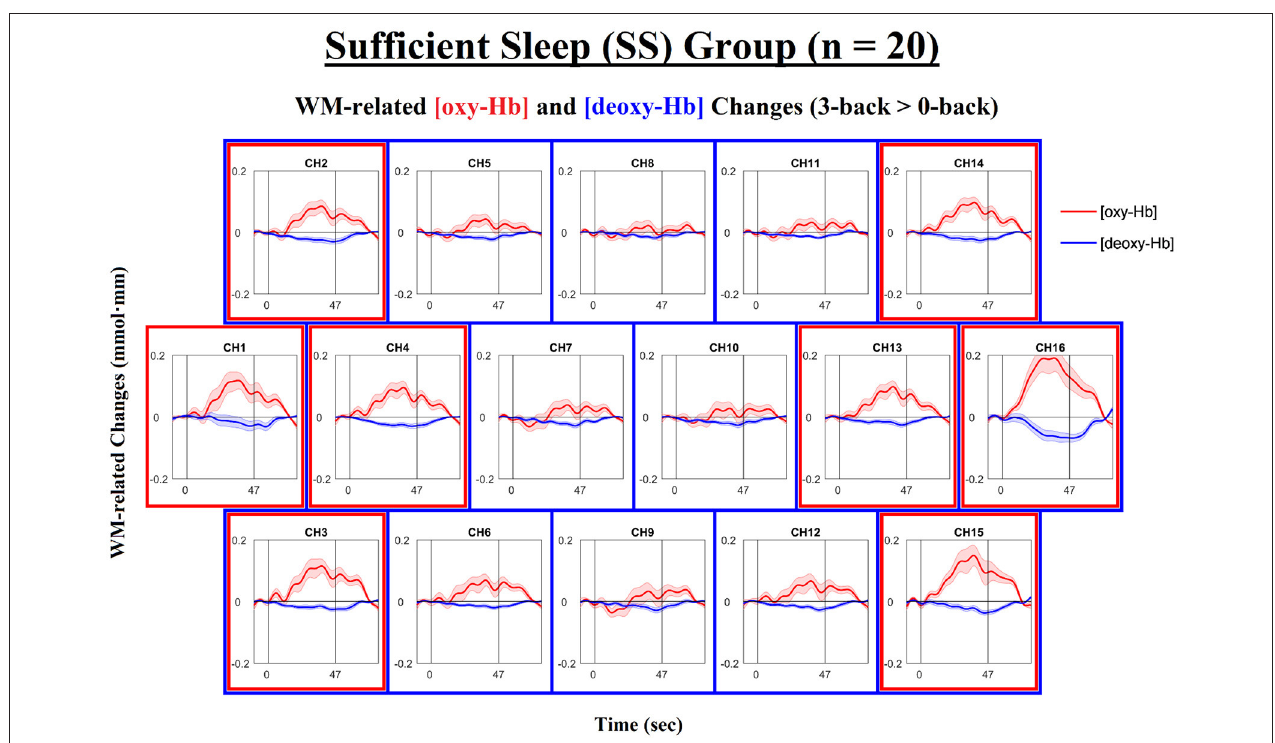
FIGURE 3 | Time courses of the working-memory-related (WM-related, i.e., 3-back minus 0-back) [oxy-Hb] and [deoxy-Hb] changes in the Sufficient Sleep group (SS; n = 20). Each n -back block started at 0s, began with an instruction cue that lasted for 5s, and ended at 47s. Channels that exhibited significant